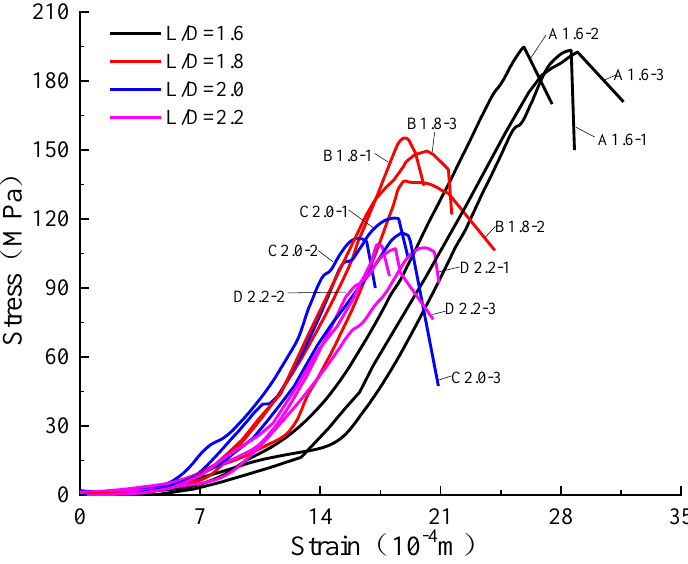
Figure 2. The rock sample stress−strain curve of different ratios of height-to-diameter. As can be seen from Figure 2 that in the uniaxial compression test of sandstones with different height-to-diameter ratios, the change trends of the stress − strain curves are the same. They all experienced the microcrack compaction stage, the elastic deformation stage, the stable crack development stage, and the crack uneven development stage. After reaching the peak strength, the stress drop occurs, the sample is damaged, and the bearing capacity is lost. The failure of the sandstone sample shows a vital brittleness feature. With the increase in the height − diameter ratio, the ultimate failure strength of the sample gradually decreased, indicating that the strength of the rock is related to the change in the